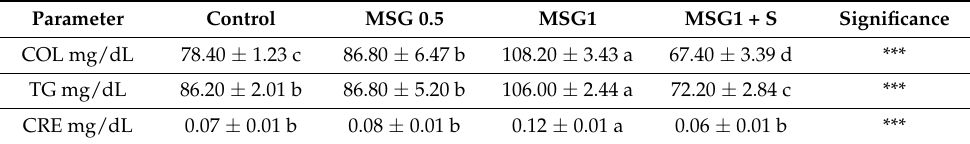
Table 1. Average values for biochemical parameters: COL, TG, and CRE. The standard deviation of the mean ( n = 5) is included. Parameter Control MSG 0.5 MSG1 MSG1 + S Significance COL